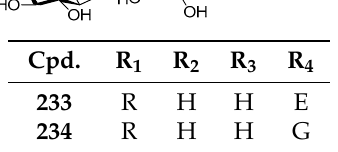
Figure 45. Structures of compounds 233 – 234.